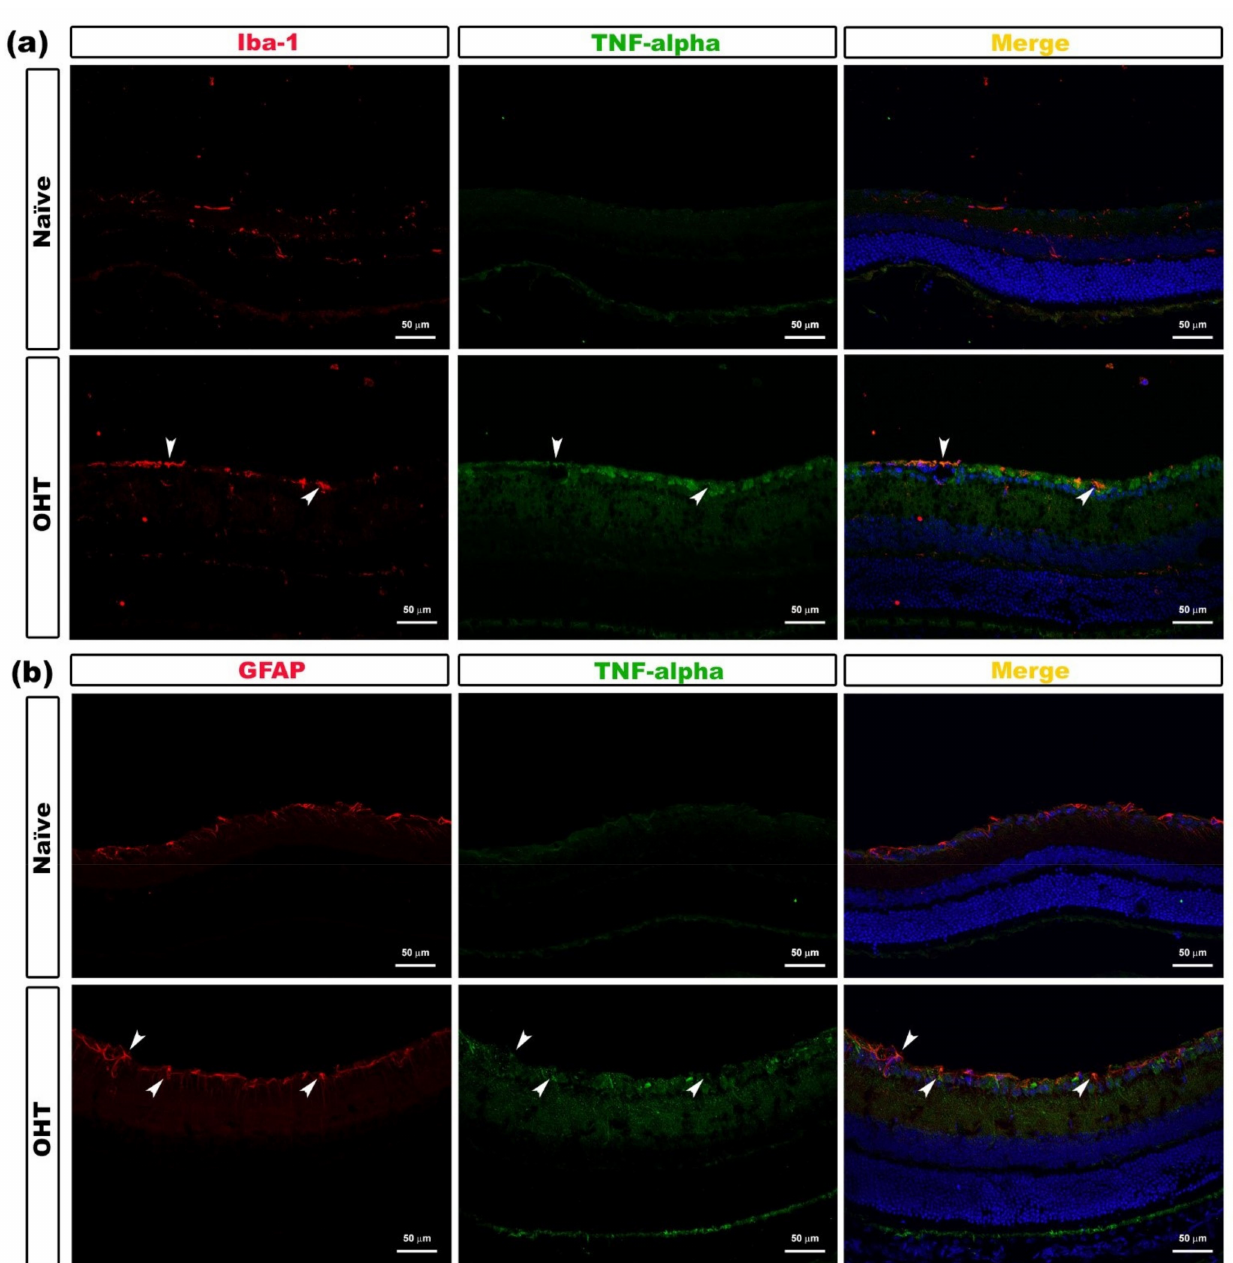
Figure 6. TNF- α expression in OHT eyes after laser-induced ocular hypertension (OHT). ( a , b ) Immunohistochemical study of TNF- α expression in OHT eyes at 1 day after unilateral laser-induced OHT. Retinal sections were immunolabeled with antibodies to TNF- α (green), Iba-1 (red in ( a )), and GFAP (red in ( b )). Merge (yellow). ( a ) Arrowheads point to the co-expression of Iba-1 and TNF- α in OHT eyes. ( b ) Arrowheads show the co-expression of GFAP and TNF- α in the OHT eyes. Abbreviations: OHT (ocular hypertension); TNF- α (tumor necrosis factor-alpha); GFAP (glial fibrillary acidic protein); Iba-1 (ionized calcium-binding adaptor molecule